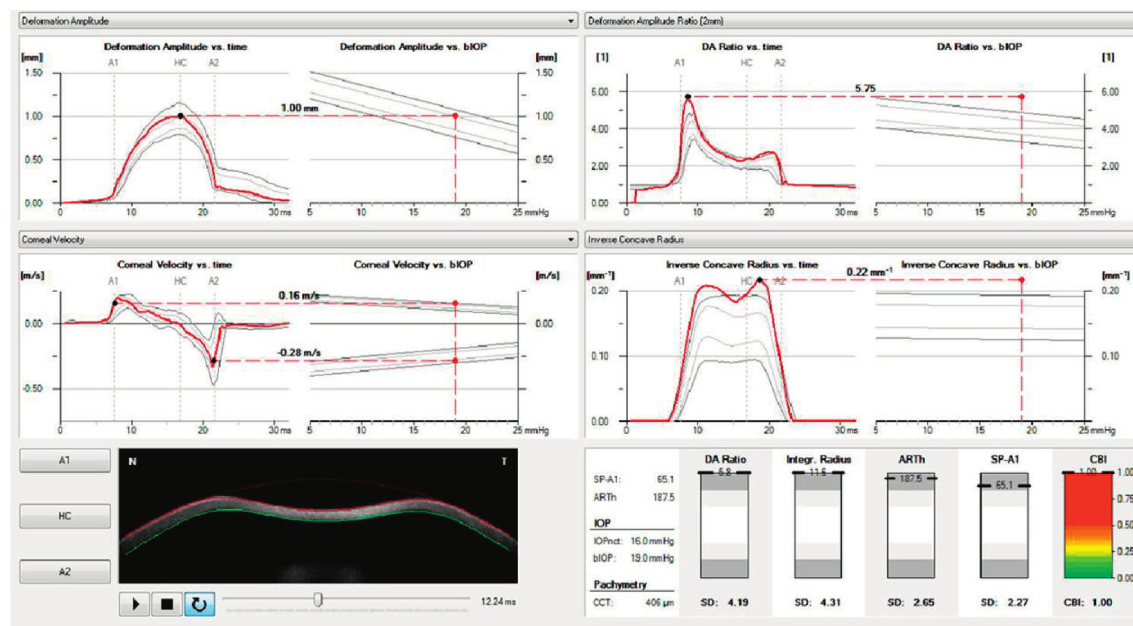
Figure 1: Vinciguerra screening report displays DCR parameters of a patient with keratoconus in comparison with normative values. The ARTh and SP-A1 are lower, and the DA ratio, integrated radius, and CBI are higher in keratoconus compared to normal